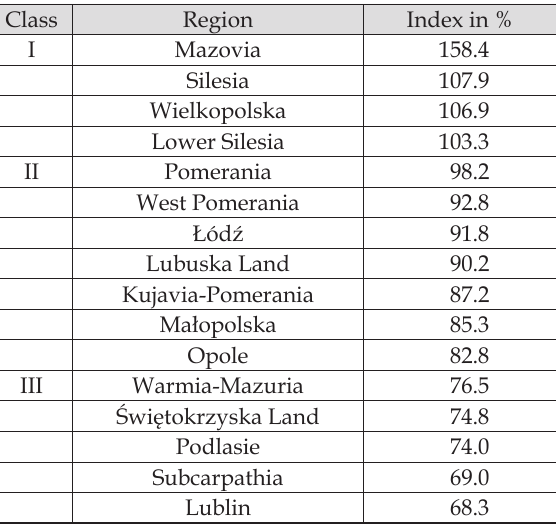
Table 1. Classification of regions by per capita GDP